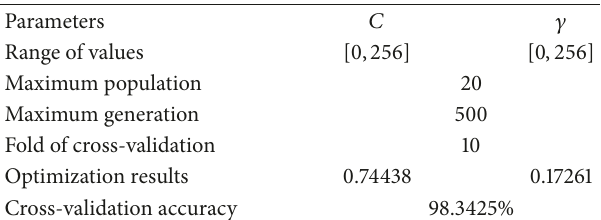
Table 4: Parameters setting and optimization results of the Genetic Algorithm.